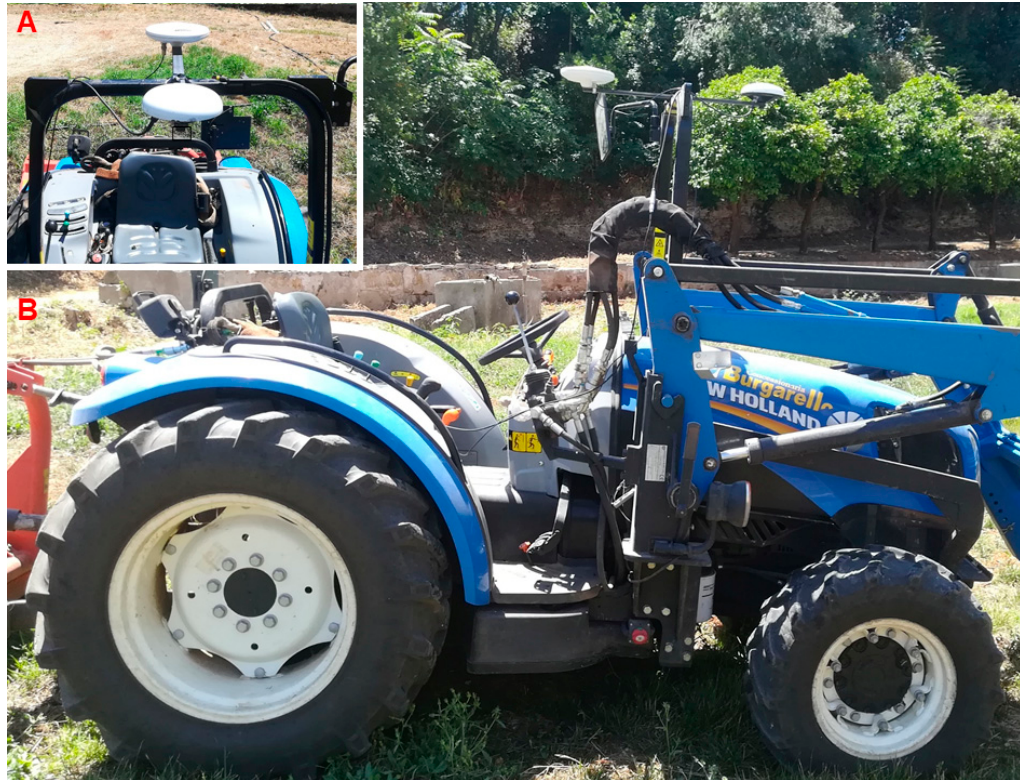
Figure 2. Antennas ( A ) and wheeled tractor ( B ) used during the field tests.